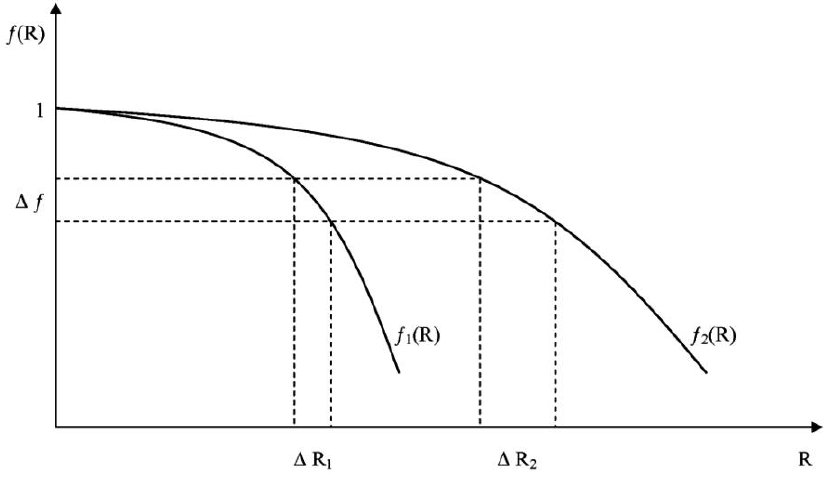
Fig. 2. Geometric proof of